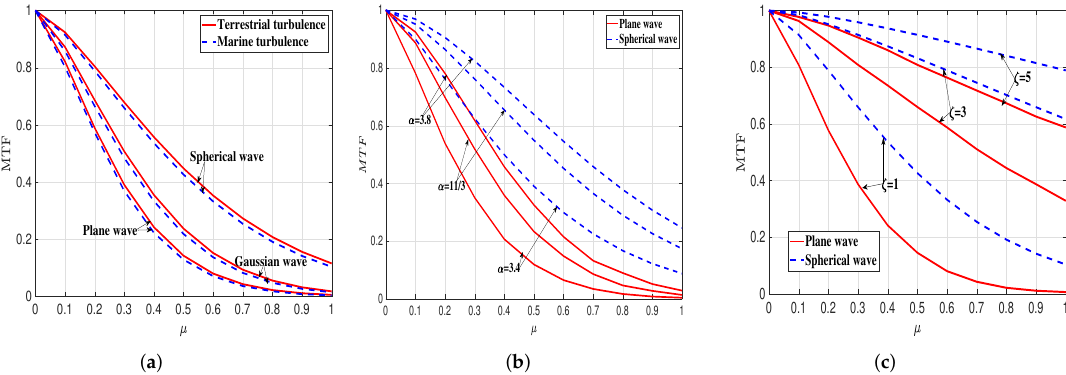
Figure 5. Long-exposure MTF as a function of normalized spatial frequency for ( a ) plane, spherical, and Gaussian beam wave; ( b ) plane and spherical wave with various α ; and, ( c ) plane and spherical wave with various